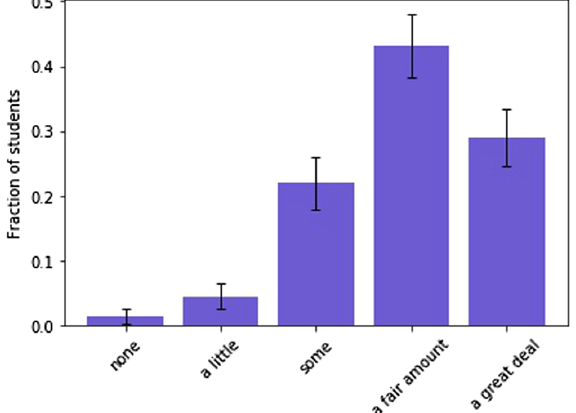
FIG. 1. Student responses to the question How much did you engage in real-world science research? Uncertainties are calcu- lated using the binomial confidence interval with α ¼ 95%